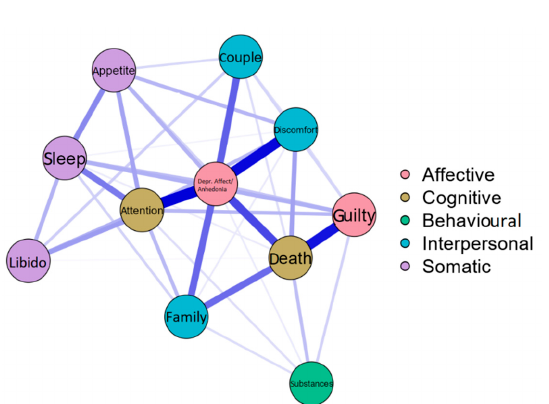
Figure A2. Estimated correlation network for the factors evaluated with the DCET (temporal mo- ment ‘year’). Note —The most central nodes in the network are “depressed mood/anhedonia” and “attention”. Notably, the strongest connections are established between these two nodes and be- tween “depressed mood/anhedonia” and “clinical distress”, as well as between “thoughts of death” and “guilt”.